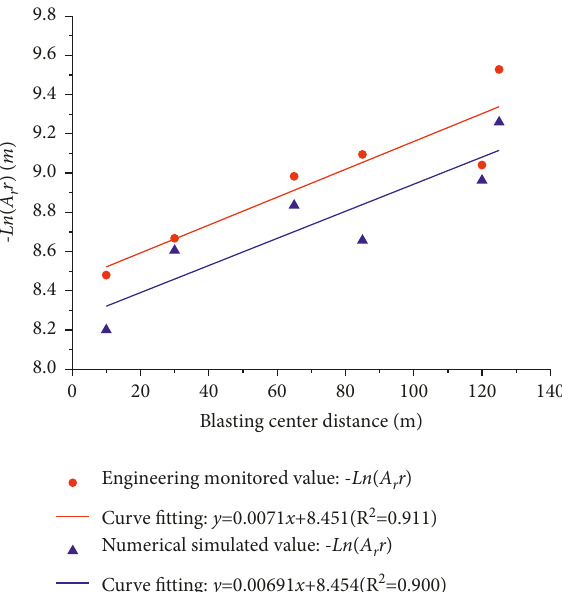
Figure 10: Relationship between the reduced distance and the vibration